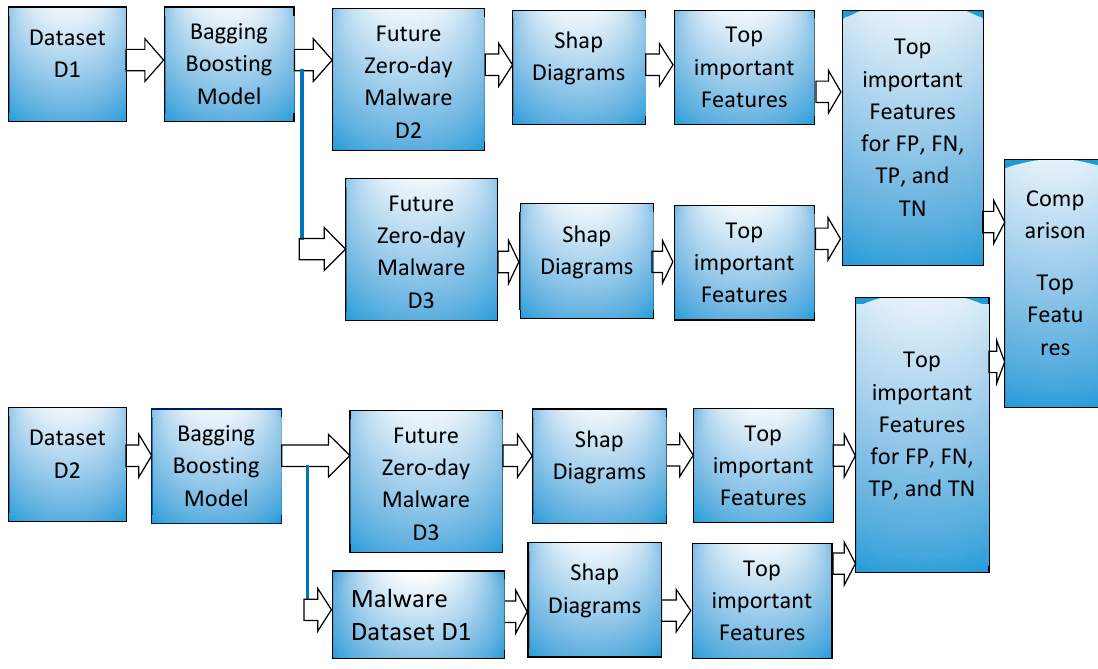
Figure 3. Block diagram for the